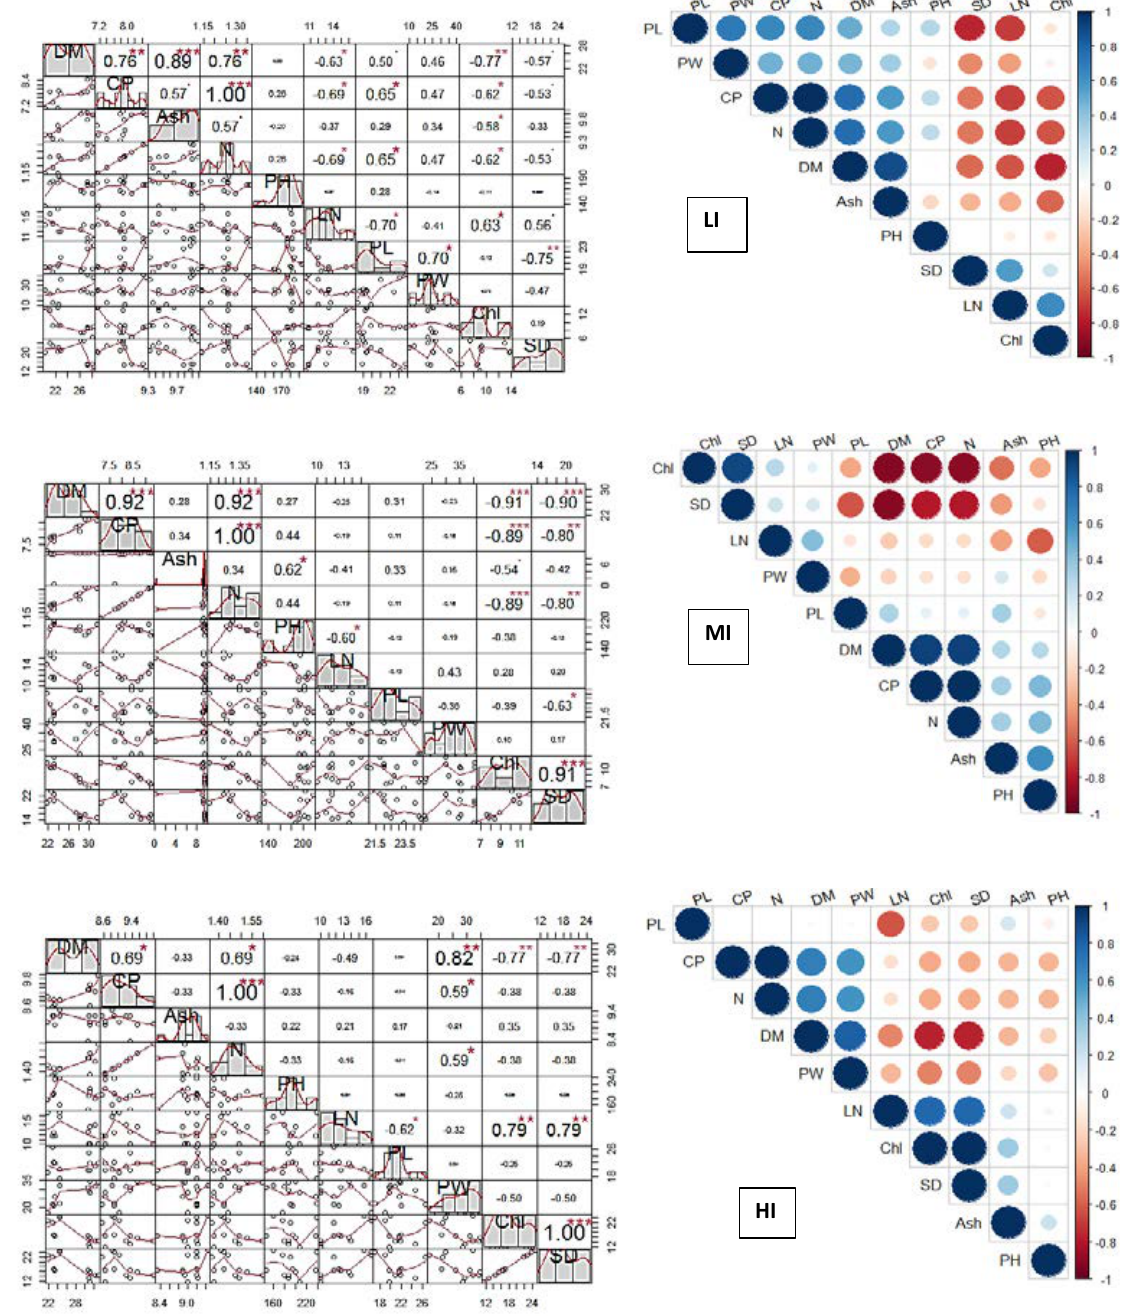
Fig. 4: Correlation plot of sorghum traits under irrigation levels; (HI): High irrigation, (MI): Medium irrigation and (LI): Low irrigation. DM: dry matter, CP: crude protein, PH: plant height, LN: leaf number, PW: panicle weight, PL: Panicle lengh, Ash: Ash content, and Chl: Total